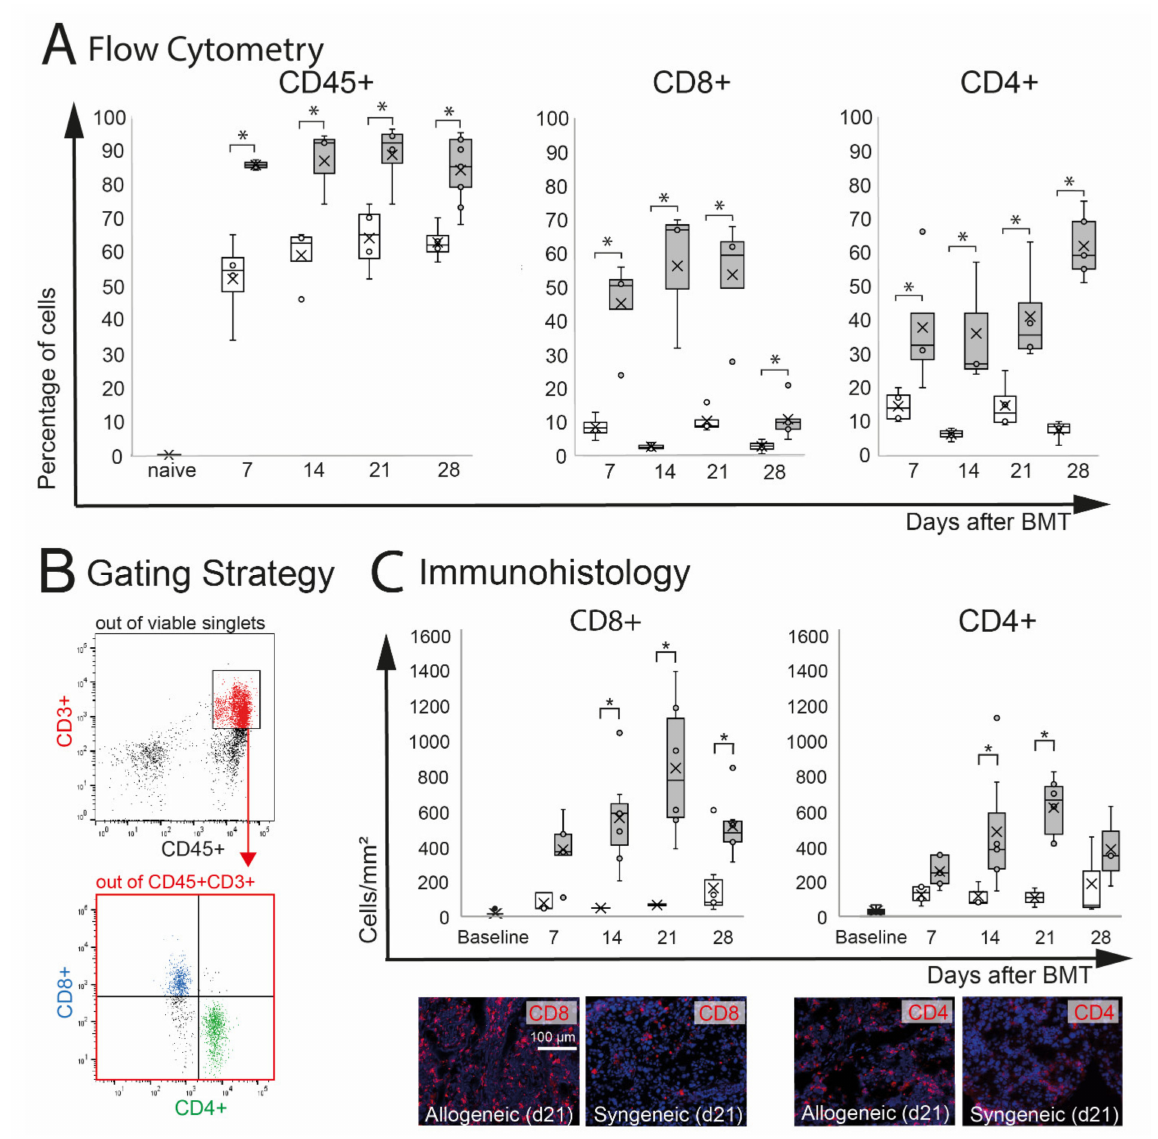
Figure 3. Effect of chemotherapy conditioning followed by either syngeneic (B6-B6) or allogeneic (129s-B6) BMT on extra-orbital lacrimal glands. ( A ) Flow cytometry analysis of ELG tissue. A significant infiltration with CD45+ leucocytes was observed in both groups compared to naïve mice. Allogeneic mice developed more pronounced CD45+ infiltration compared to syngeneic control mice. In allogeneic mice, the numbers of CD8+ and CD4+ cells were significantly increased compared to syngeneic mice. ( B ) Gating strategy. After excluding dead cells and doublets, viable cells were gated on CD45+CD3+ cells, and the number of CD8+ and CD4+ T cells was calculated. ( C ) Immunohistochemistry of frozen sections. The number of positive cells was counted manually and calculated per mm 2 . The results confirmed significant infiltration with CD8+ and CD4+ T cells in ELG tissue of allogeneic mice. In allogeneic mice, a higher number of CD8+ and CD4+ cells per mm 2 was found at d14 and d21 after BMT (* p ≤